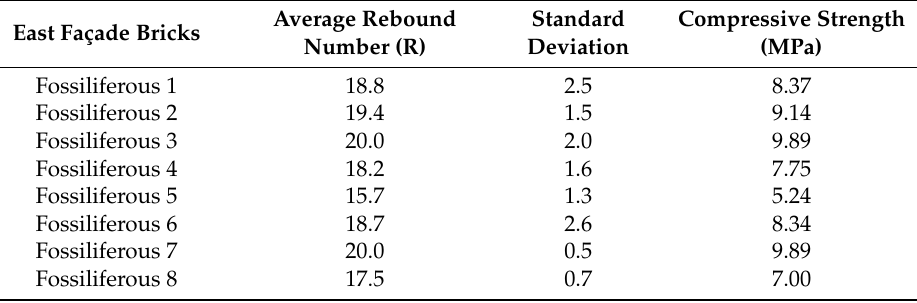
Table 5. Rebound hammer test results for the fossiliferous stone elements of the cloisonn é